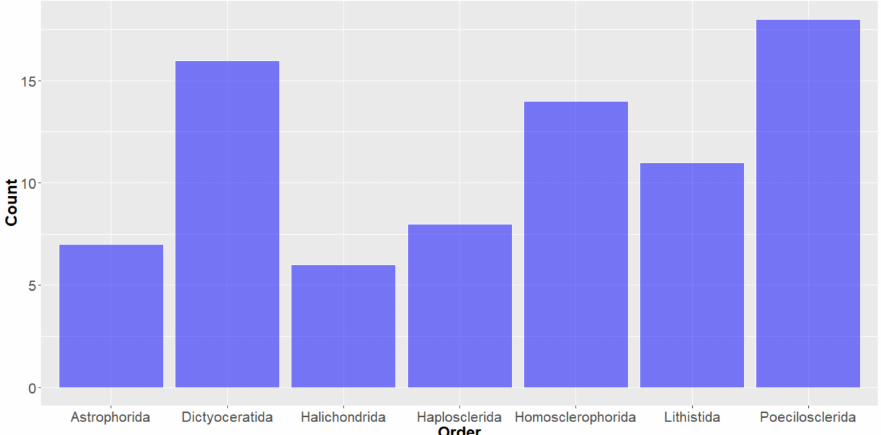
Figure 4. Number of natural products isolated from deep-sea marine organisms of the Porifera Phylum in the Animal Kingdom, by order.